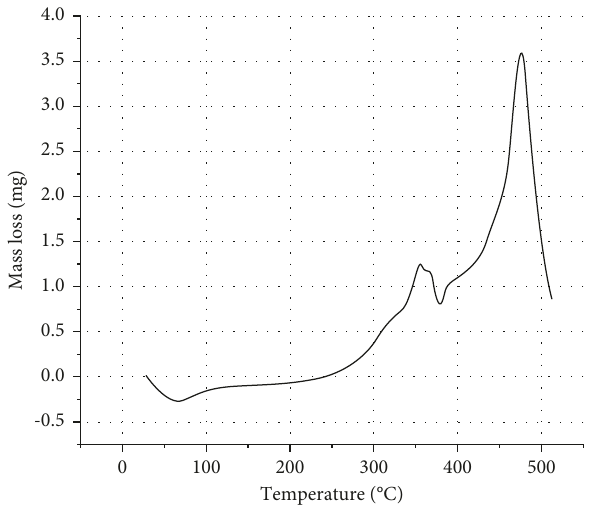
Figure 3: Thermogravimetry analysis of sisal